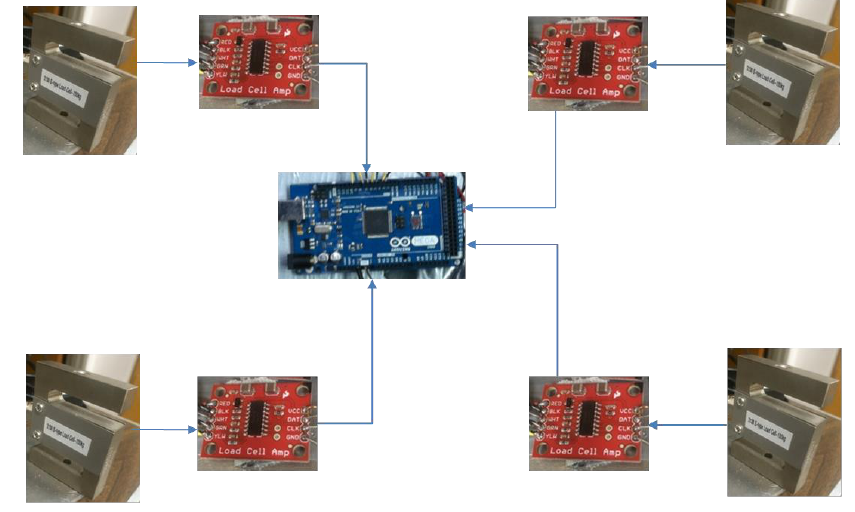
Figure 3. Schematic diagram of the load cells and amplifiers.